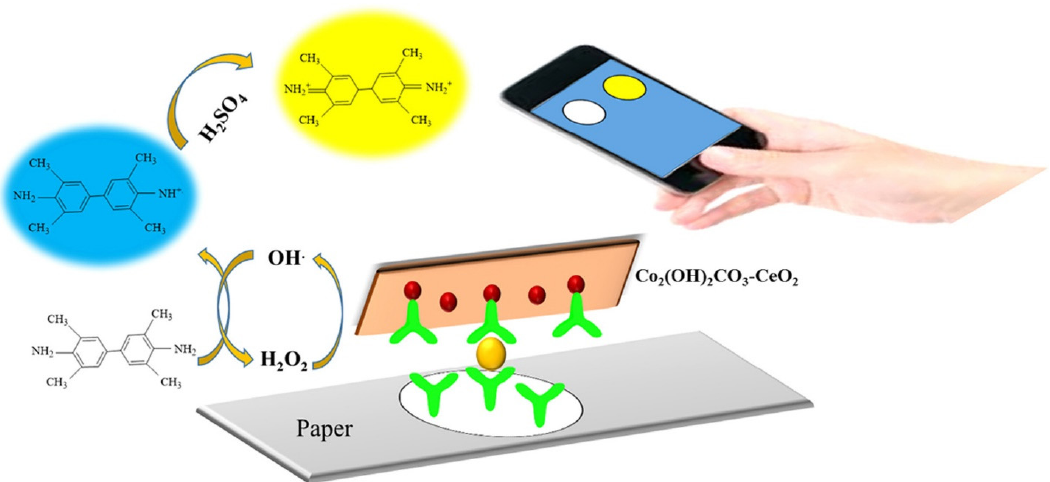
Figure 5. Graphic illustration and assay procedure for CEA detection using the microfluidic paper- based analytical device. Reproduced with the permission of [43]. Copyright 2018, Elsevier. Kitchawengkul et al. have successfully developed a paper-based sensor for the detec- tion of total cholesterol (TC) from whole blood with aid of nitrogen-doped carbon dots (N-CDs) coupled with a 3D micro fl uidic platform [44]. This sensor functions as a simple, cost-e ff ective, sensitive and selective alternative for TC determination in blood samples, when compared with conventional colorimetric measurements.